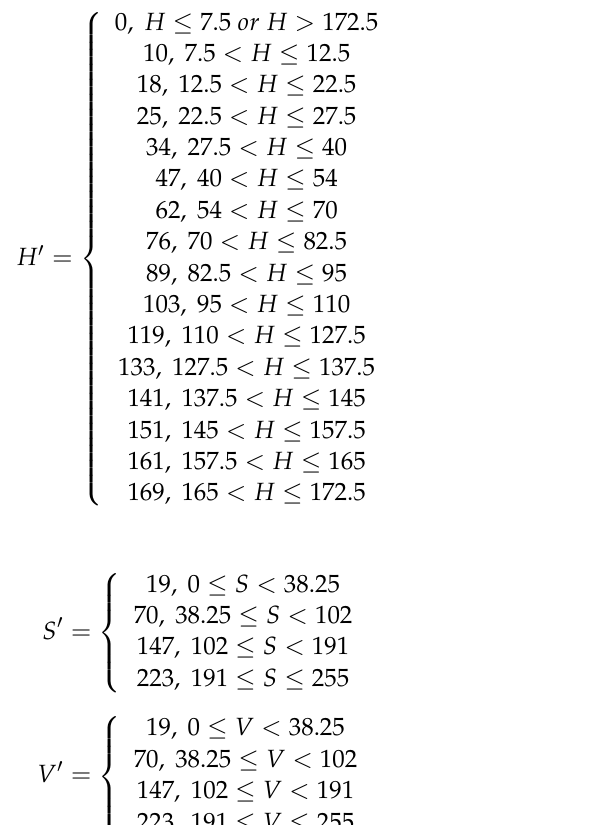
Figure A4. The automatic interpreted color patches in photographs. Step 6: Generate IDF_ASCII files. Fragstats (version 4.2, McGarigal, University of Massachusetts, Amherst, MA, USA) was used to calculate the metrics of color patches patterns. The photograph was not supported as the input files, and it should be converted to the files in IDF_ASCII format. In this step, every pixel was replaced by the number of its color category, and a two-dimensional matrix formed of 600 × 400 numbers was gener- ated. As shown in Figure A5, the pattern of patches in IDF_ASCII file was similar to that in Figure A5a, and the IDF_ASCII file was formed by numbers as shown in (b).